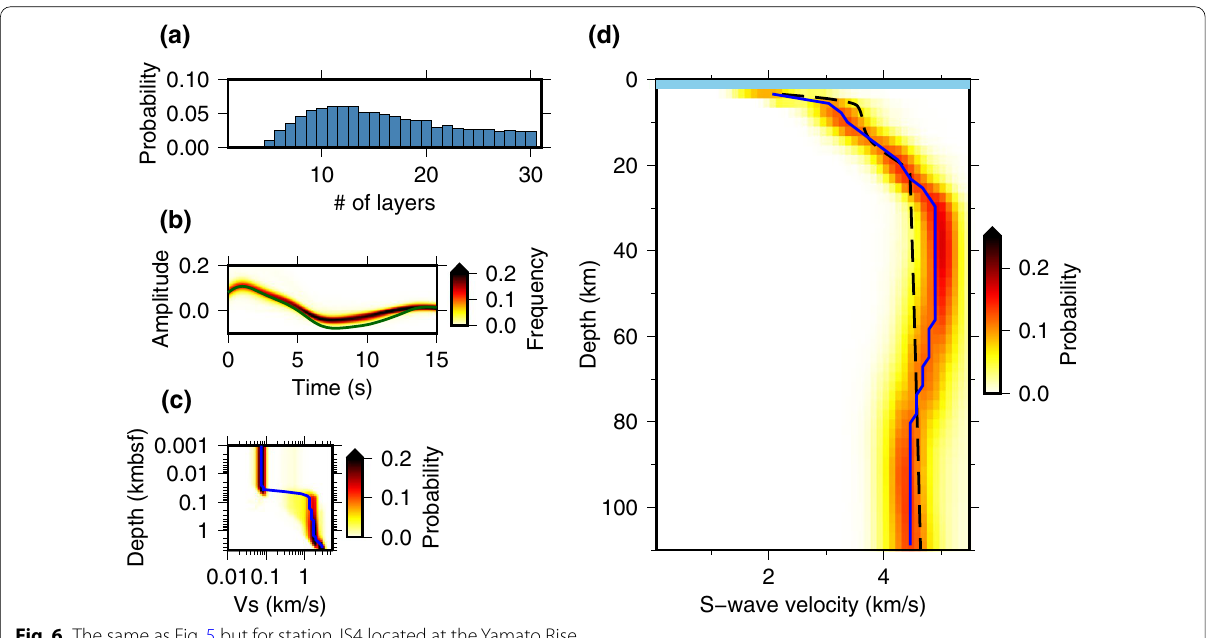
Fig. 6 The same as Fig. 5 but for station JS4 located at the Yamato